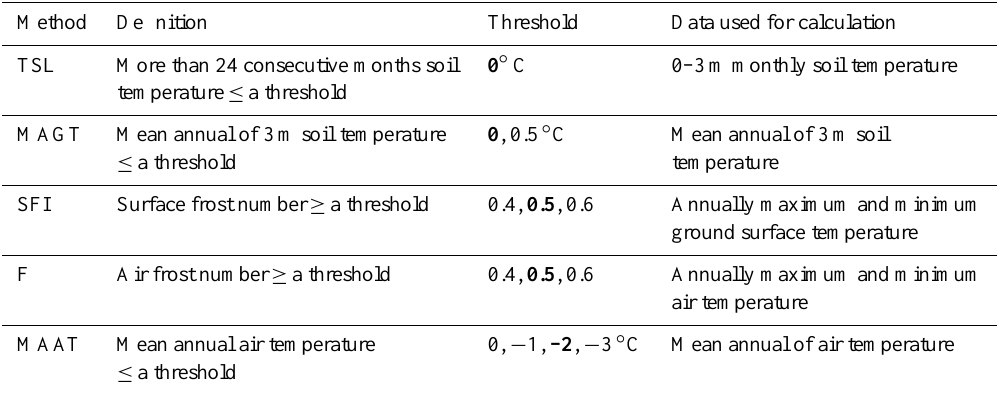
Table 2. The five diagnostic methods and threshold values used to derive permafrost. The thresholds commonly used in the literature and in this paper are marked in bold.